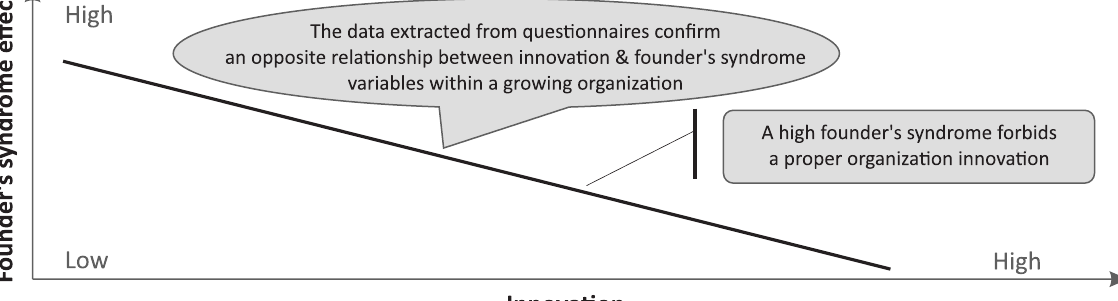
Figure 2. Negative correlation of founder’s syndrome &